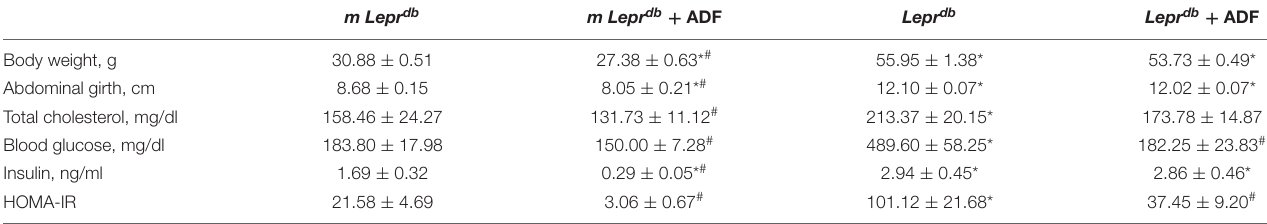
TABLE 1 | Basic characteristics.